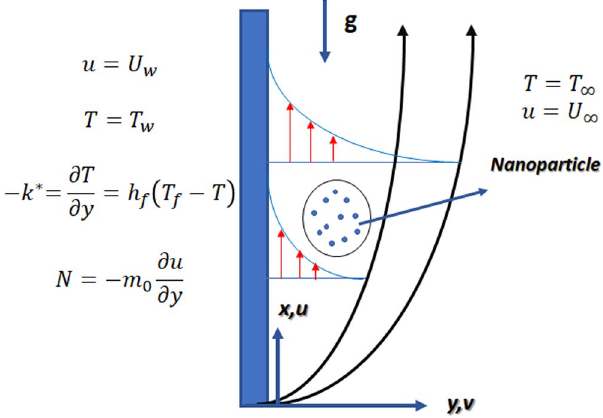
Figure 1. Schematic diagram of the